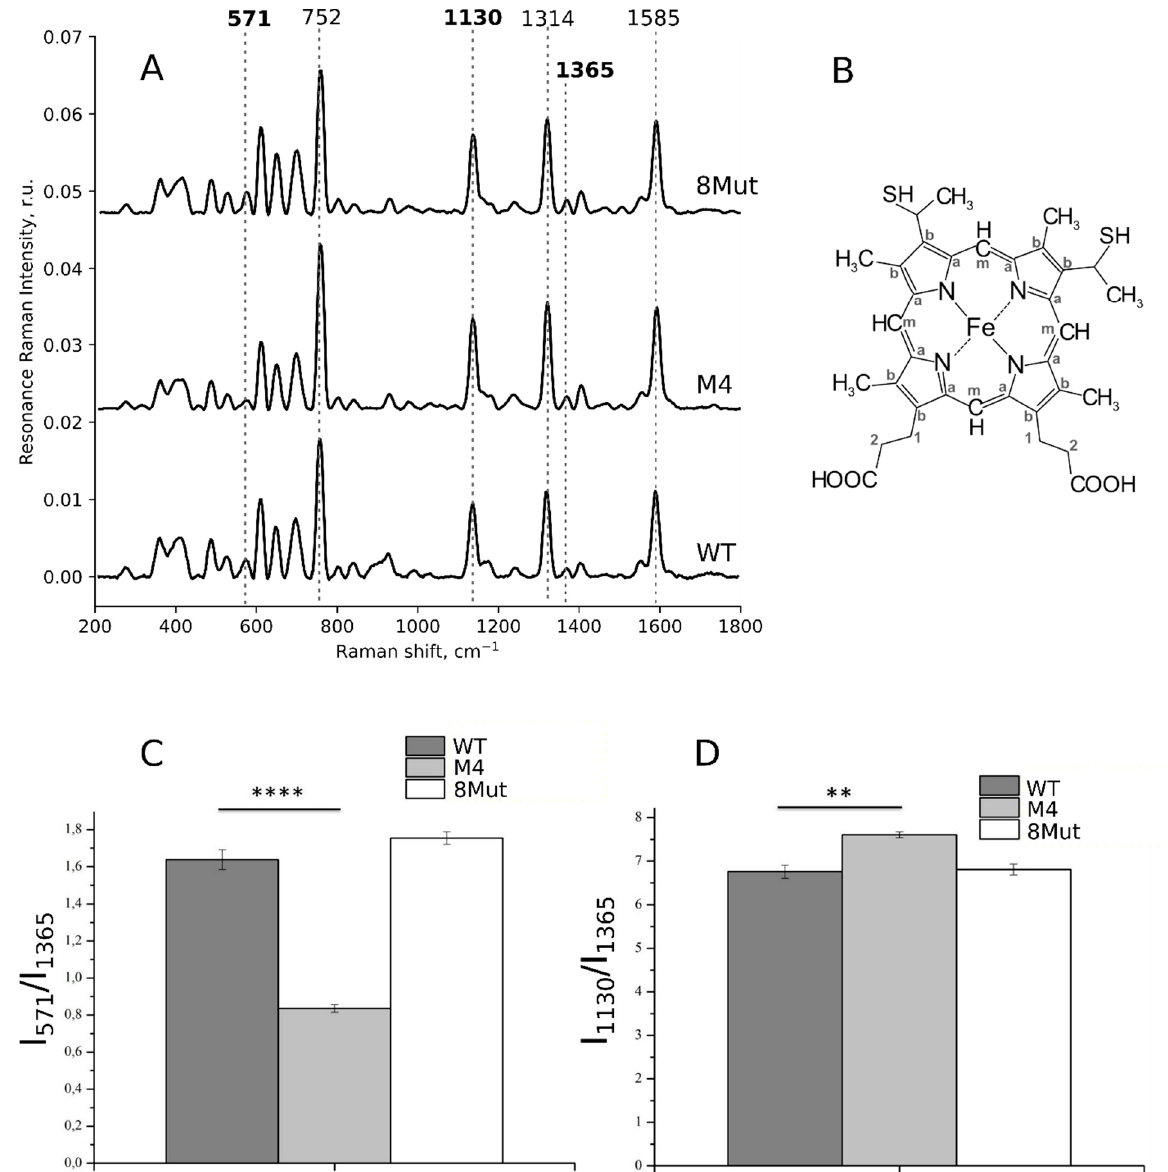
Figure 4. ( A ) Resonance Raman spectra of reduced WT CytC and its mutant forms in PBS buffer solution (10 − 5 M) with four and eight site-directed mutations (M4 and 8Mut, respectively). The reduction of CytC was performed by adding SDT powder to the experimental chamber 2–3 min before the spectrum registration. For a clearer representation, spectra are normalized on the sum of all spectrum intensities and shifted vertically. Dotted lines show the maximum positions of the most intensive peaks and of a peak corresponding to ruffled heme conformation (at 571 cm − 1 ) or a planarity-insensitive peak (at 1365 cm − 1 ). Numbers above peaks show maximum peak positions. Bold numbers demonstrate peaks used in the study. ( B ) The structural formula of heme c . ( C , D ) Ratios of peak intensities calculated from the resonance Raman spectra of reduced WT CytC and its mutants with four and eight site-directed mutations (dark grey, light grey, and white boxes, respectively). The I 571 /I 1365 ratio corresponds to the probability of the ruffled heme conformation and the I 1130 /I 1365 ratio corresponds to the probability of vibrations of the heme CH 3 -side radicals (right figure). Data are presented as mean values and the error of the mean, n = 7. Statistics were calculated with ANOVA (GraphPad Prism 8.0). ** p < 0.01, **** p < 0.0001. Heme conformations in oxidized WT and mutant forms of CytC in the buffer and in the membrane-bound state were studied by means of surface-enhanced Raman spectroscopy because oxidized CytC mutants possess low Raman intensity, undetectable